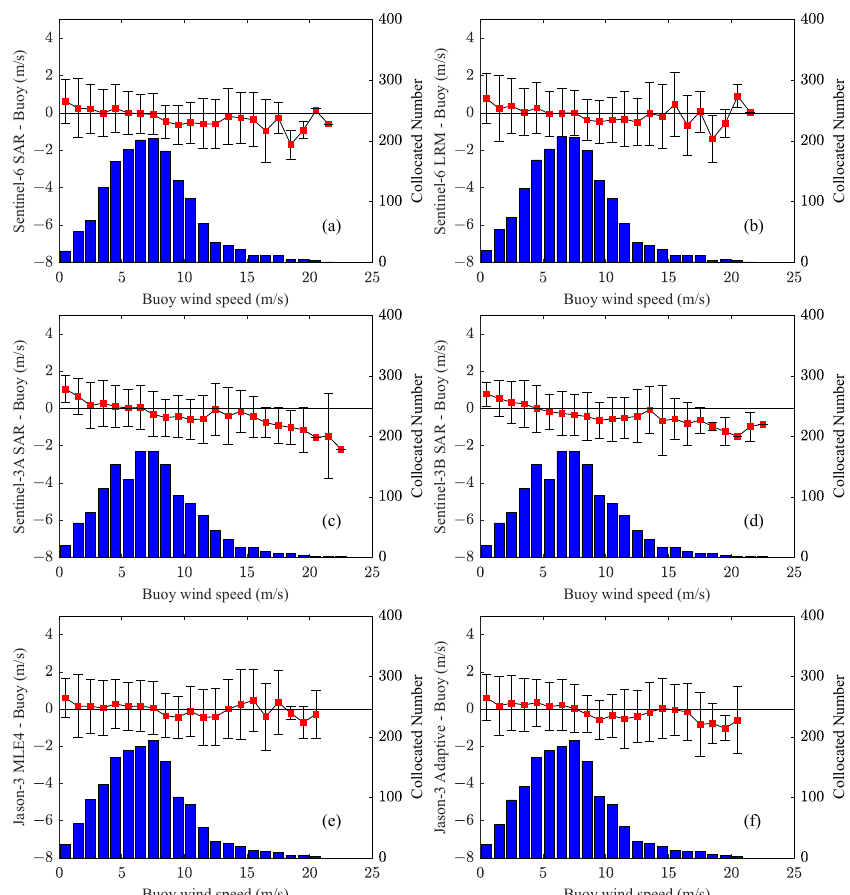
Figure 12. Bias dependency of altimeters and buoy wind speed measurements for ( a ) Sentinel-6 SARM, ( b ) Sentinel-6 LRM, ( c ) Sentinel-3A SARM, ( d ) Sentinel-3B SARM, ( e ) Jason-3 MLE4 and ( f ) Jason-3 adaptive wind speed measurements.